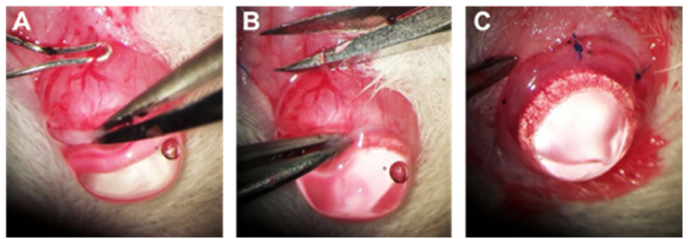
Figure A1. Episcleral vein occlusion on a rat eye. The EVO operation has several intermediate steps: ( A ) Incision of the conjunctiva, exposure of the episcleral veins and closure of the truncti by thermo-occlusion. ( B ) Dissection of the empty vessel to prevent bypass formation. ( C ) Closure of the incision by surgical knots.